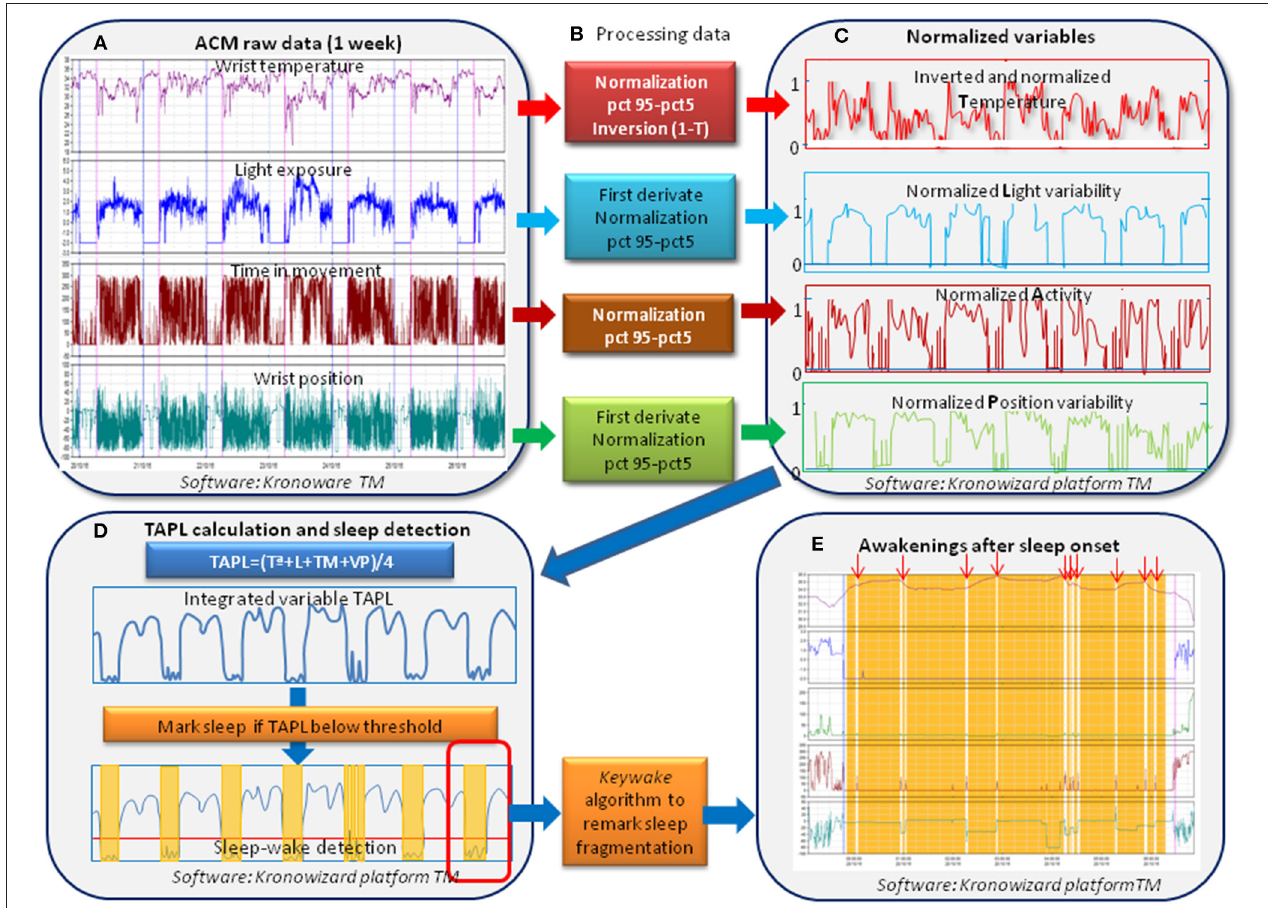
FIGURE 1 | Sequence for data processing and algorithms used for automatic detection of sleep and wake periods. Downloaded raw data from ACM device (A) were submitted to a two-phase procedure. The first procedure for automatic sleep and wake (B,C) detection used the TAPL algorithm (D) (integrating wrist temperature, motor activity, variability in wrist position and variability in light exposure), implemented on the Kronowizard website (https://kronowizard.um.es/, University of Murcia). Given that, WT rhythm is the inverse of the A, P, and L, WT values were inverted before calculating the mean of the four standardized variables. Therefore, a TAPL value of 0 indicates deep rest, characterized by immobility, vasodilation of the skin vessels, and low variability of L exposure, while 1 corresponds to wake, movement, vasoconstriction, and high light variability. A concrete period was classified as sleep when TAPL values fell beneath a preset threshold (D) , previously validated by